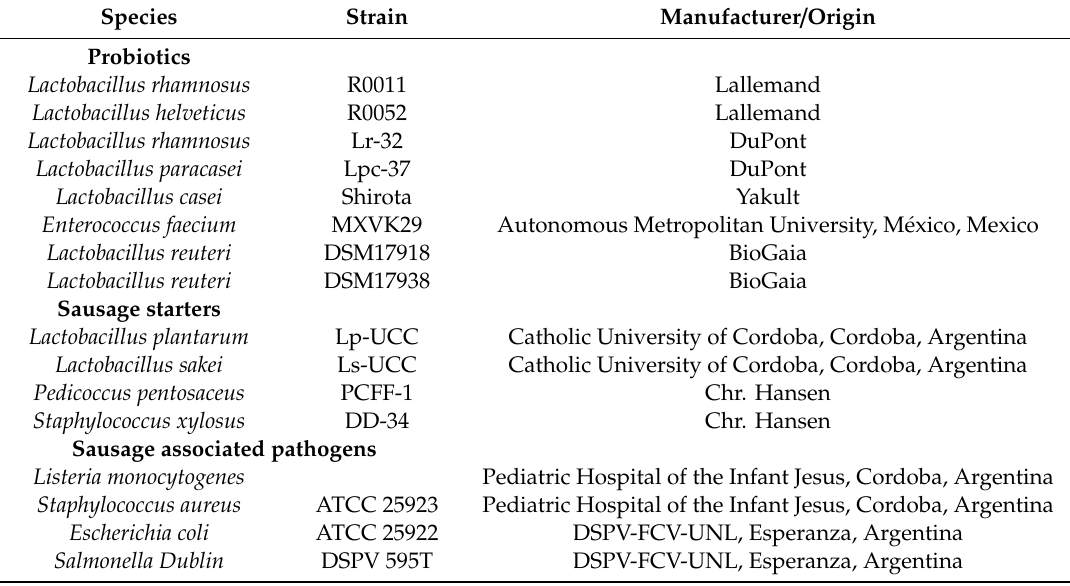
Table 1. Bacterial strains used in the